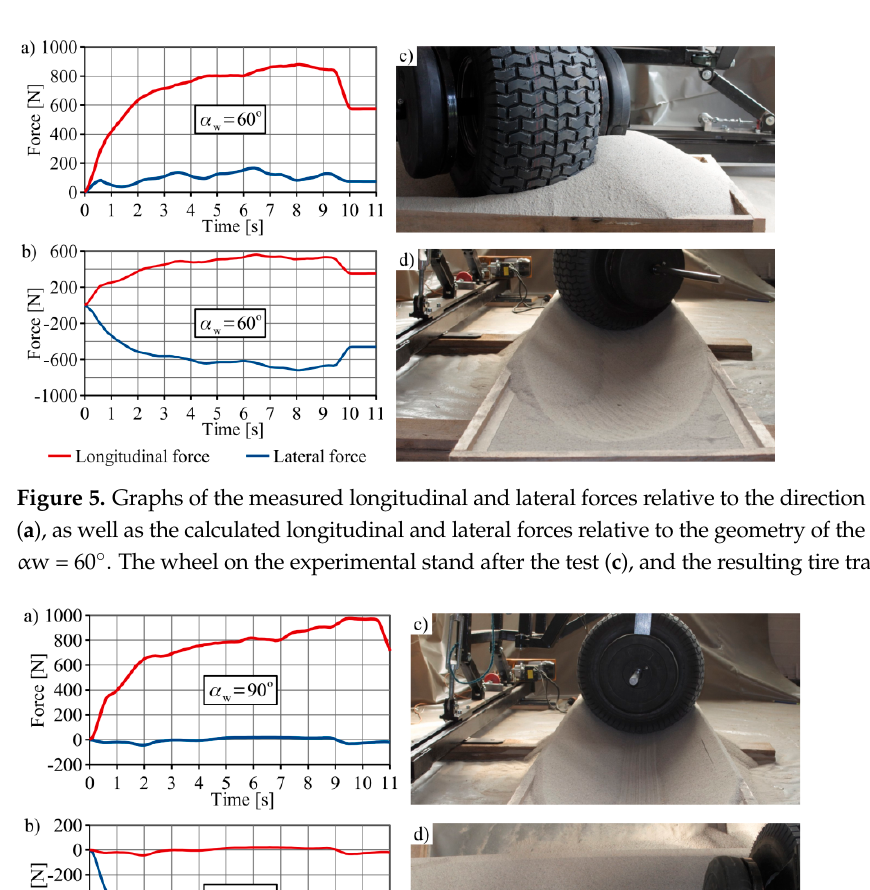
wheel ( b ), for α w = 30°. The wheel on the experimental stand after the test ( c ), and the resulting tire track ( d ) [21].